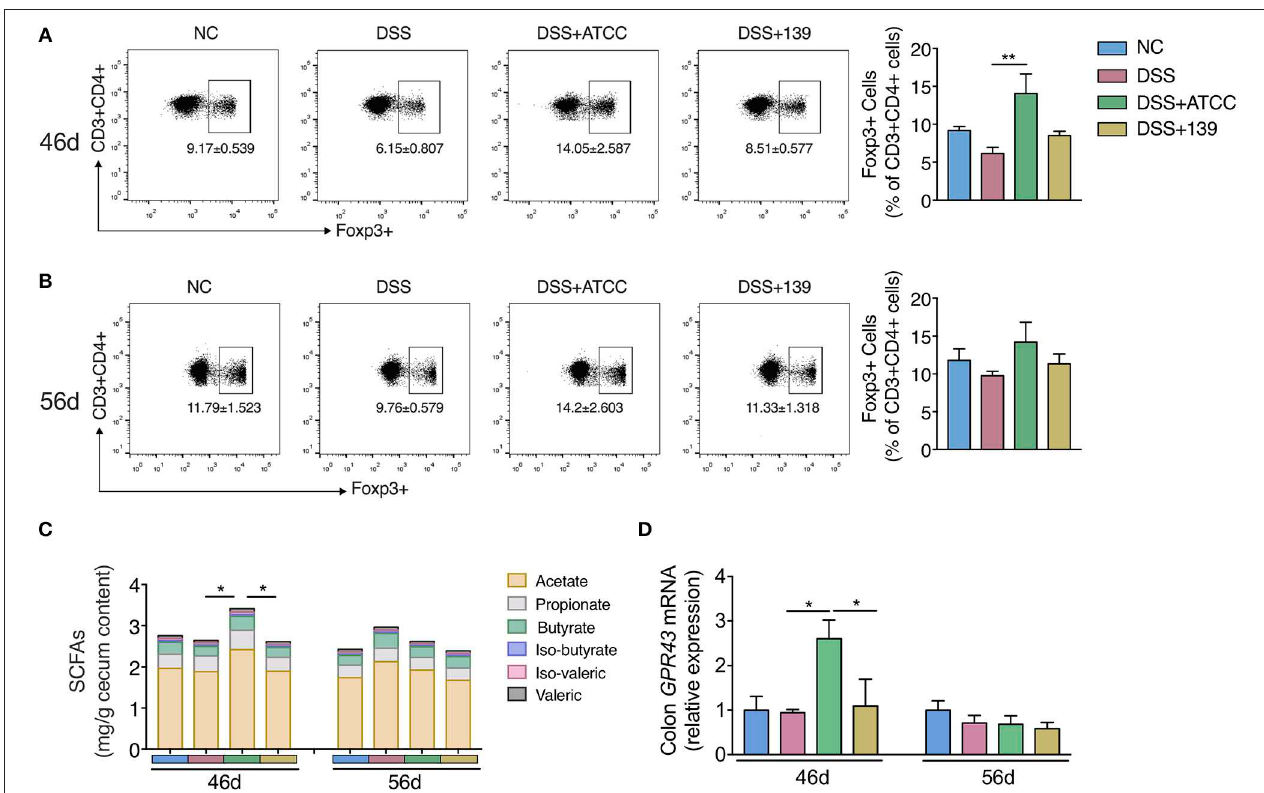
FIGURE 4 | A. muciniphila strain ATCC promoted the MLNs Treg cells differentiation and SCFAs production of mice. (A,B) The frequency of Foxp3 + Treg cells among the CD4 + T cells (CD3 + CD4 + cells) in MLNs of mice at day 46 ( n = 5 per group) and day 56 ( n = 4 per group) detected by flow cytometry. (C) The content of SCFAs (acetate, propionate, butyrate, iso-butyrate, iso-valeric, and valeric) in cecum content of mice at day 46 and day 56 ( n = 5 per group). (D) mRNA expression of GPR43 in colon of mice ( n = 5 per group). All the data are shown as mean ± s.e.m. Values of each group were calculated by one-way analysis of variance (ANOVA) followed by Tukey’s post-hoc test. * P < 0.05, ** P <